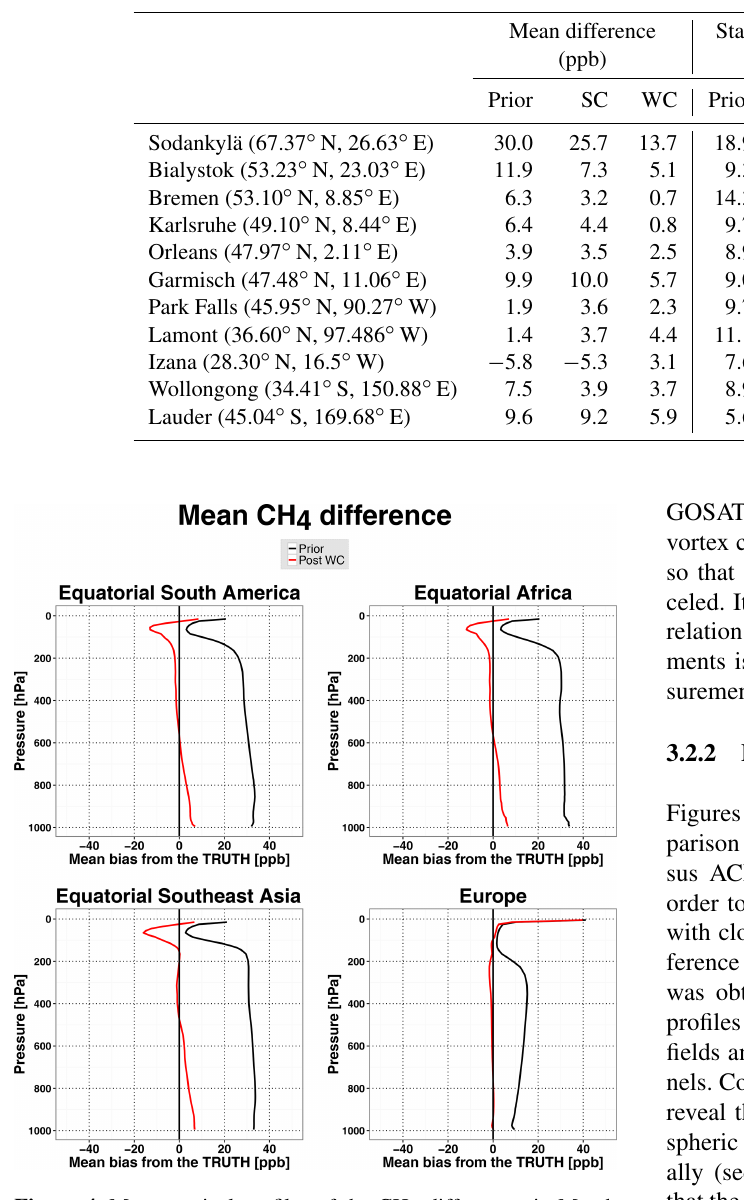
Figure 4. Mean vertical profiles of the CH 4 differences in March 2010 in the OSSE with biased chemistry for the four regions de- picted in Fig. 3. The differences are between (black lines) the a pri- ori and the true CH 4 state and between (red lines) the WC optimized state and the true CH 4